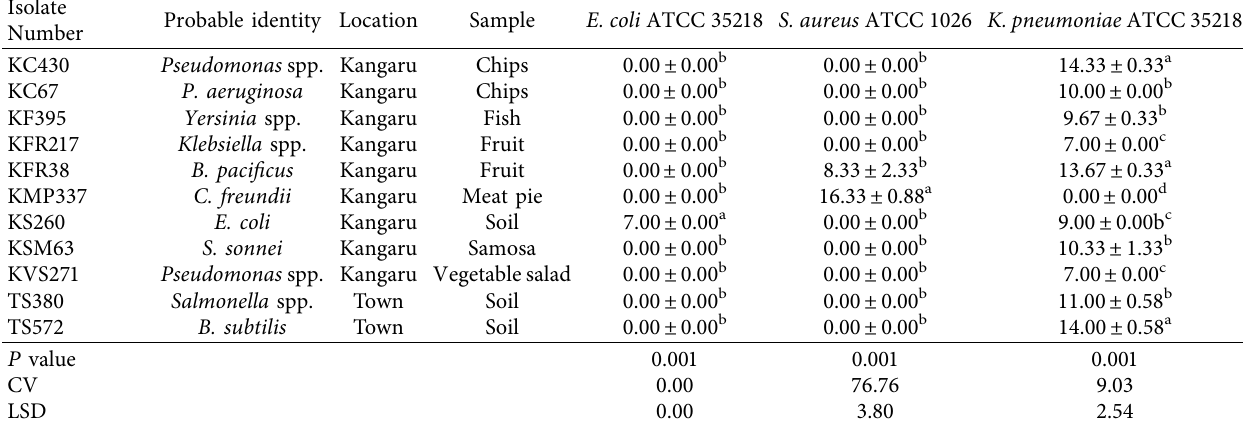
Table 4: Antibiosis effect of antibiotic-resistant bacteria isolated from vended food and soil on laboratory strains of bacteria.